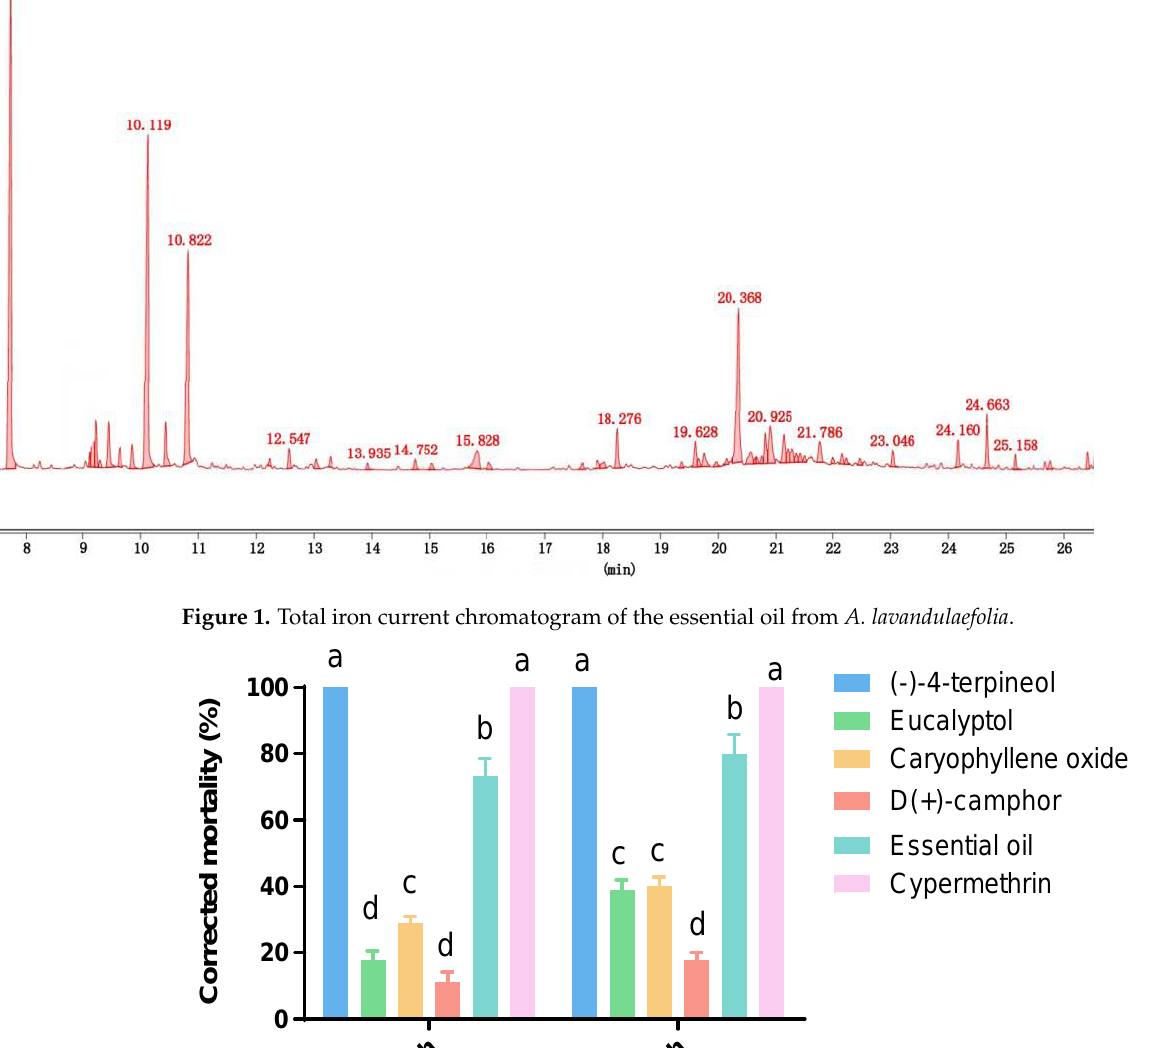
Figure 2. Toxicity of major compounds of A. lavandulaefolia essential oil against P. xylostella larvae in comparison to whole essential oil and positive control by contact bioassays after 12 h and 24 h of topical application. The values are expressed as the means + standard error of each experiment. Bars followed by the same letter in each time interval are not significantly different using Tukey’s HSD test at p < 0.05.